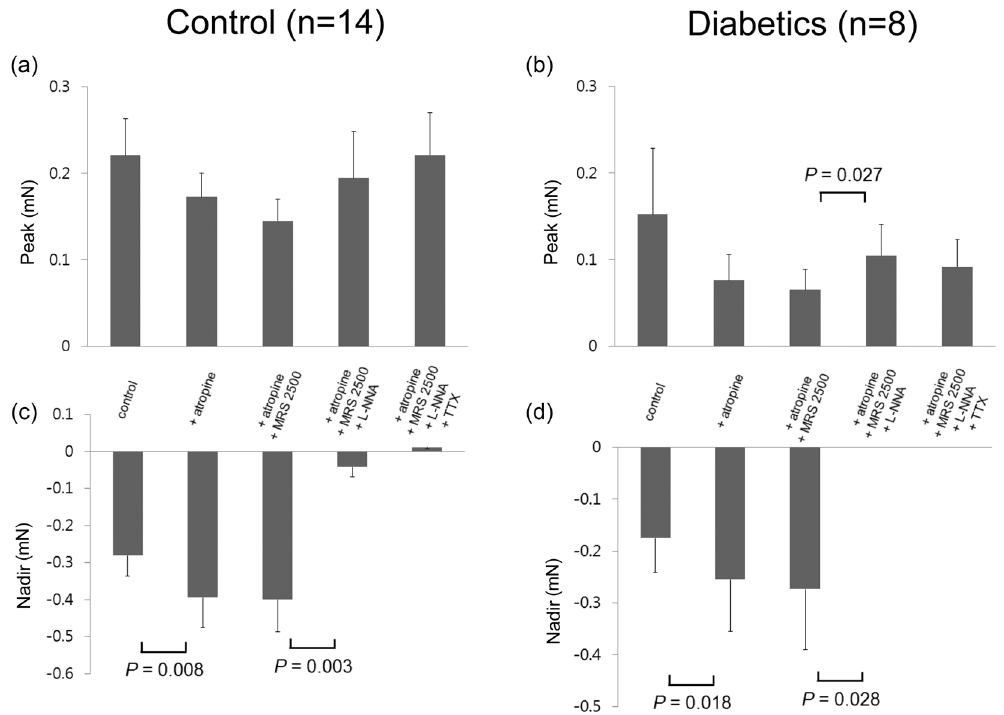
Figure 5. Electrical field stimulation (EFS)-induced response of the proximal gastric longitudinal muscle strips after serial administration of atropine, MRS2500, N-nitro-L-arginine (L-NNA), and tetrodotoxin (TTX). ( a ) No significant effects of serial administration of drugs in the control subjects. ( b ) L-NNA increased the peak in the diabetic patients. ( c ) Atropine increased the nadir but L-NNA abolished relaxation. ( d ) Also in the diabetic patients, atropine increased the nadir but L-NNA abolished relaxation. The Wilcoxon signed-rank test was used to evaluate the effects of each drug by compare values to the previous